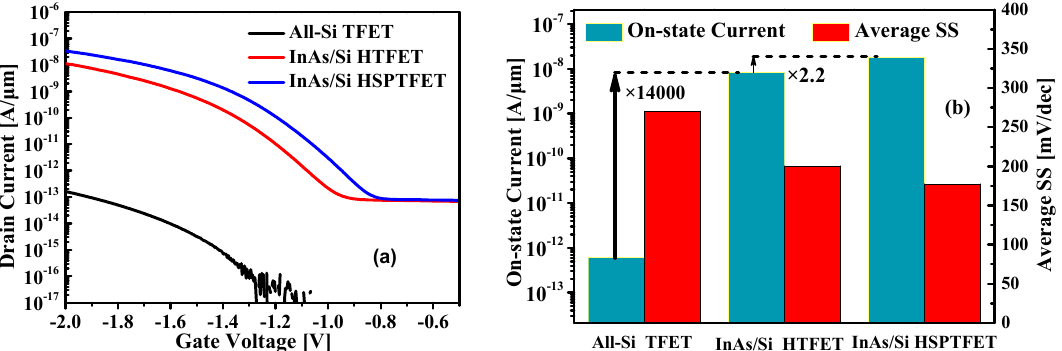
Figure 2. ( a ) Simulated I D -V G curves for different TFET configurations. ( b ) Plots for comparison of the on-state current and SS. The HSP-TFET is with the pocket doping N P = 1 × 10 19 cm − 3 and the pocket length is L P = 6 nm. The gate work function is 4.3 eV and drain bias is − 0.5 V.